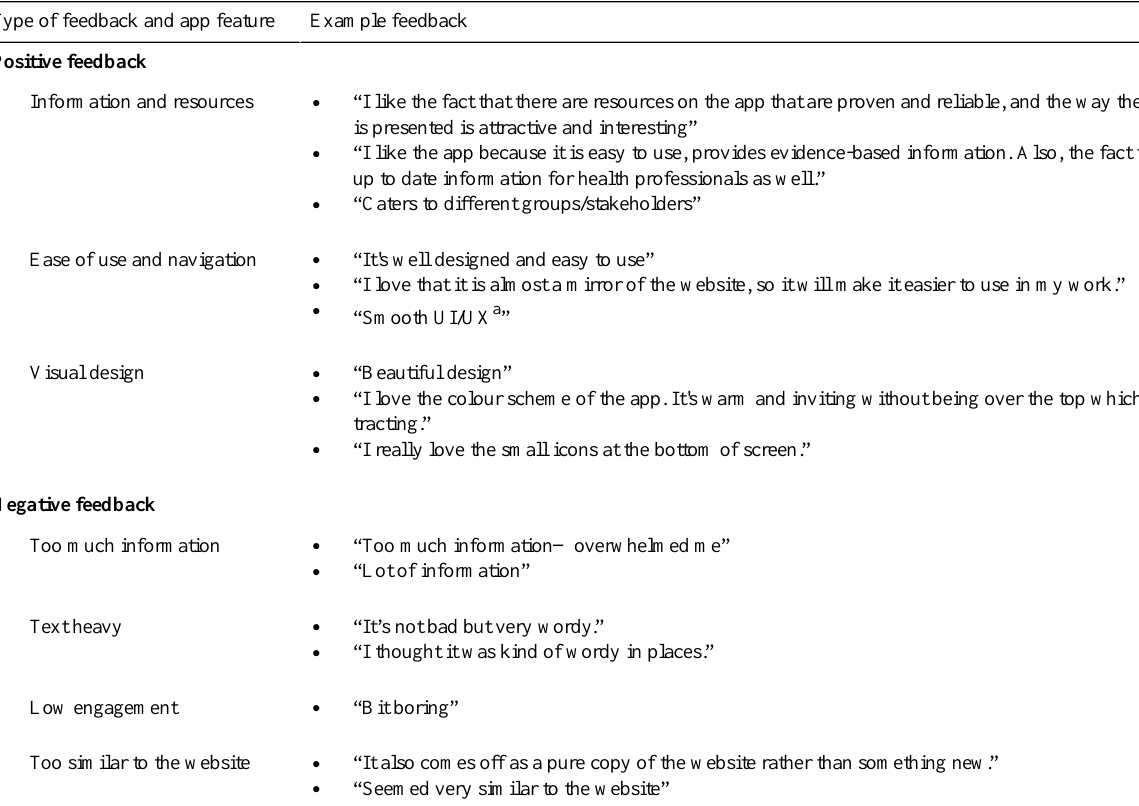
Table 2. Example feedback from end users about the beta version of the app.